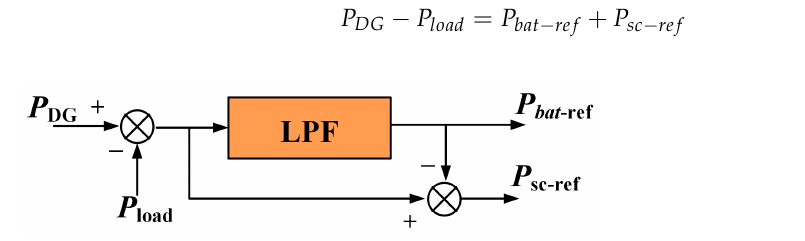
Figure 9. Control block diagram of low-pass filter (LPF).